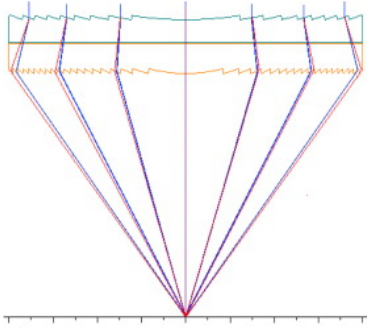
Figure 7. Fresnel lens doublet designed by Languy et al. [15]. Reprinted from F. Languy et al., Performance of solar concentrator made of an achromatic Fresnel doublet measured with a continuous solar simulator and comparison with a singlet. Solar Energy Materials and Solar Cells, 2013, 70–76, with permission from